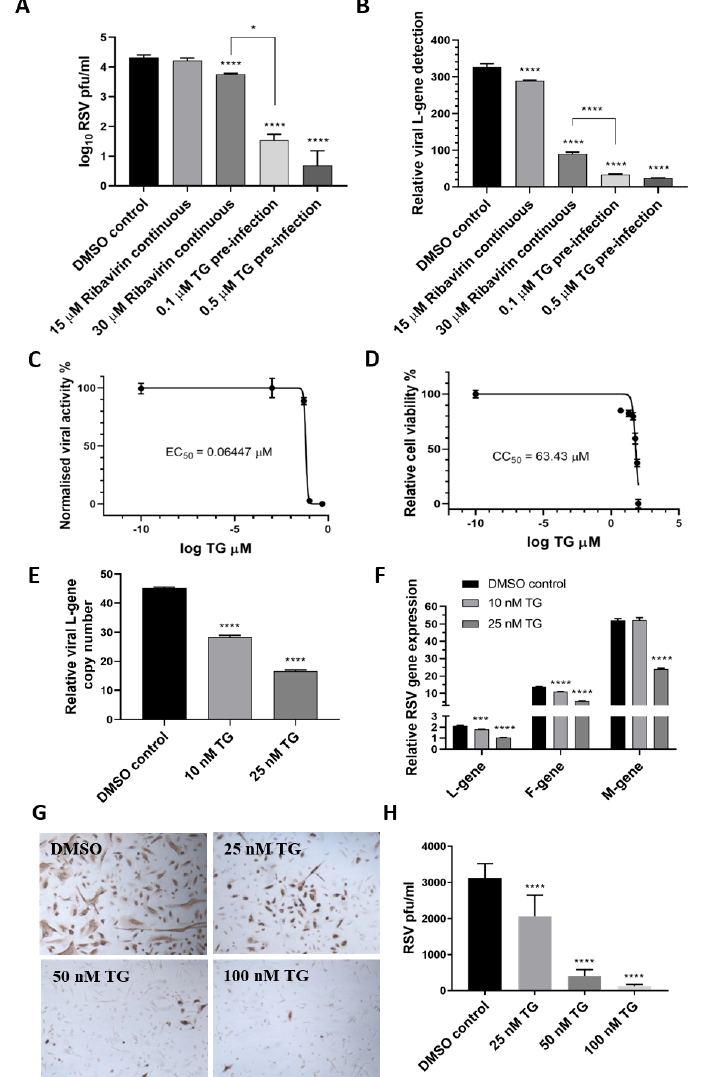
Figure 2. TG is more effective as an antiviral than ribavirin, shows a high selectivity index and blocks viral transcription and viral protein production. HEp2 cells were primed with TG, ribavirin or DMSO control, as indicated, for 30 min, washed with PBS and infected with RSV, as earlier described, in the continuous presence of ribavirin in media or in media alone (for TG or DMSO control). Media were harvested at 4 dpi for ( A ) progeny virus titration (pfu/mL) and ( B ) detection of viral L-gene RNA by one-step reverse transcription-qPCR. Unless otherwise indicated, significance by one-way ANOVA (Tukey’s multiple comparisons) is relative to the DMSO control. The corresponding selectivity index (SI) of TG in RSV infection of HEp2 cells is estimated at 984 ( C , D ). The effective concentration (EC) and cytotoxic concentration (CC) of TG against RSV in HEp2 cells were determined by pfu/mL virus titrations and luminescence cell viability assays, respectively, over a pre-infection priming range of TG. SI = CC 50 /EC 50 = 63.43/0.06447 = 983.9. EC 90 = 84.55 nM. NHBE cells were primed with TG or the DMSO control, as indicated, for 30 min, washed with PBS and infected with RSV at 0.1 MOI. At 48 hpi, media were harvested for the detection of the viral L-gene RNA by one-step reverse transcription-qPCR ( E ), and total RNA was extracted for cDNA conversion to quantify the expression of viral genes (L-gene, F-gene and M-gene) normalised to 18s rRNA ( F ). Significance by one-way ANOVA (Dunnett’s multiple comparisons) ( E ) and by 2-way ANOVA (Tukey’s multiple comparisons) ( F ) is relative to the DMSO control. TG also inhibited viral F-protein production in NHBE cells. Cells were primed with TG or the DMSO control, as indicated, for 30 min, washed with PBS and infected with RSV at 0.05 MOI for 48 h and directly immunostained for the presence of RSV F-protein ( G , H ). Images captured at 100 times magnification. There was a clear reduction in the number of RSV-positive cells (pfu) with an increasing priming dose of TG. Significance by one-way ANOVA (Dunnett’s multiple comparisons) is relative to the DMSO control. * p < 0.05, *** p < 0.001 and **** p <